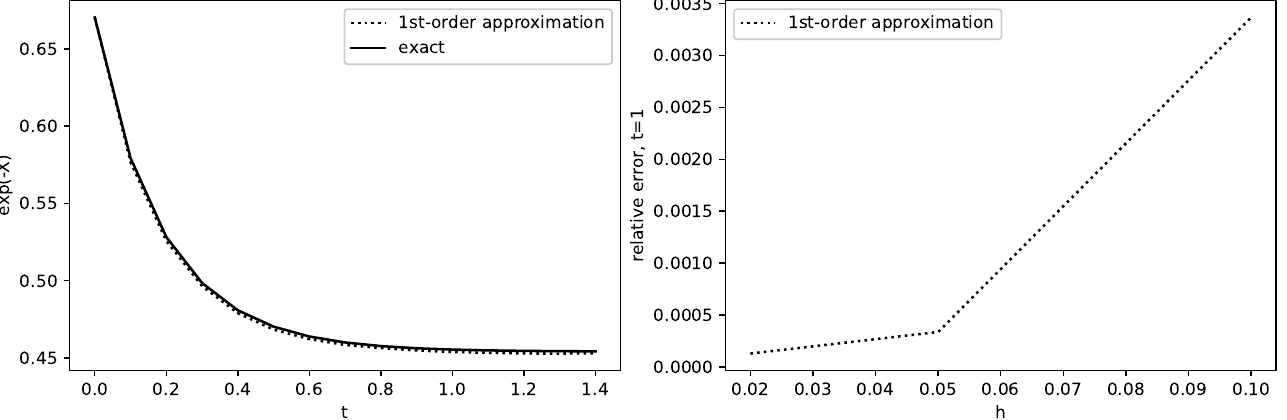
) and E f ( X x ) as functions of t and h for f ( x ) = e − x : x = 0.4, t t